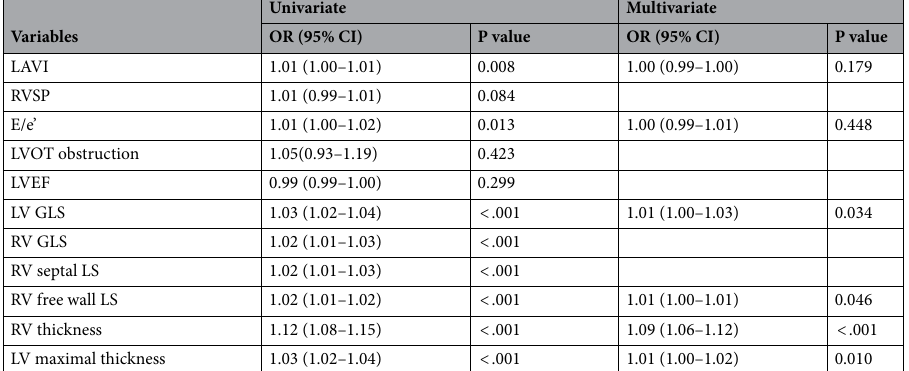
Table 5. Univariate and multivariate logistic regression analysis to estimate association between echocardiographic parameters and right ventricular involvement in hypertrophic cardiomyopathy. OR odds ratio, CI confidence interval, LAVI left atrial volume index, RVSP right ventricular systolic pressure, LVOT left ventricular outflow tract, LVEF left ventricular ejection fraction, LV left ventricle, RV right ventricle, GLS global longitudinal strain, LS longitudinal